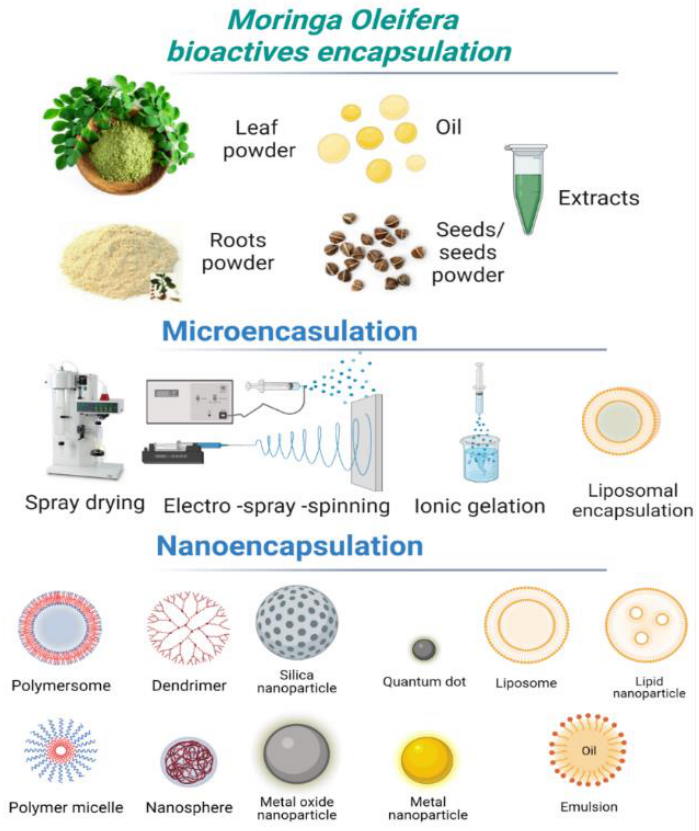
Figure 3. Most-studied encapsulation methods for M. oleifera bioactive compounds (created with BioRender.com).